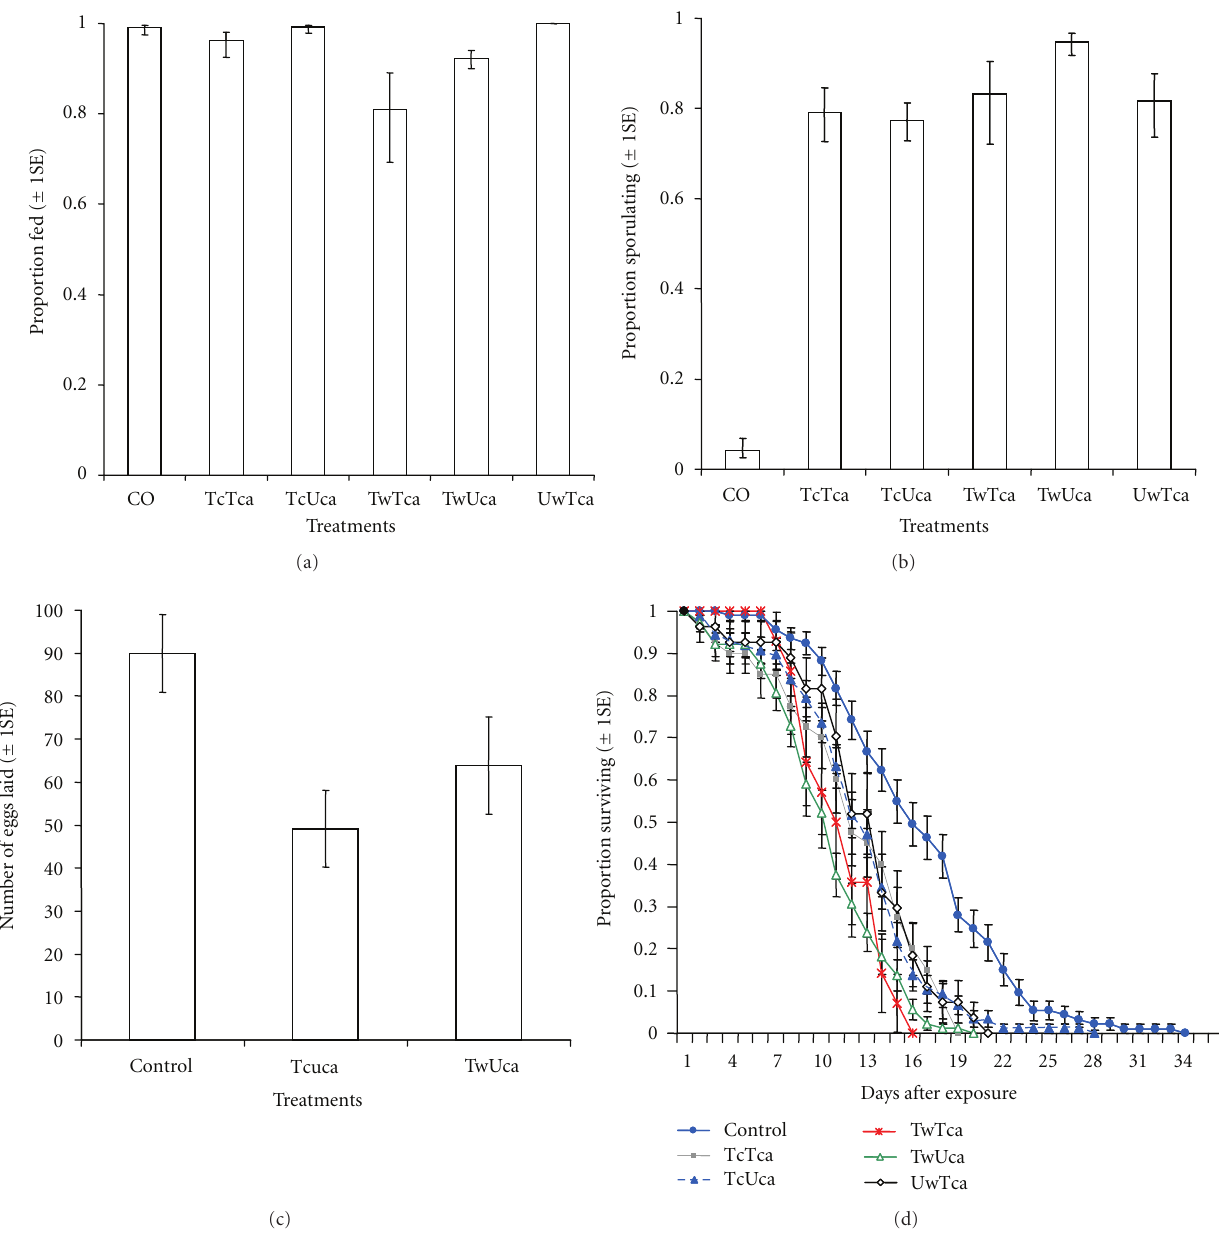
Figure 4: E ff ects of M. anisopliae IP 46 against wild exophilic An. arabiensis . (a) Estimated proportion ( ± 1s . e) of fed mosquitoes after exposure to fungus-treated and untreated calf inside experimental hut. (b) Estimated proportion ( ± 1s . e) of infected mosquitoes after exposure to fungus-treated and untreated surfaces. (c) Estimates ( ± 1s . e) of the mean number of eggs laid by mosquitoes after exposure to fungus-treated and untreated surfaces. (d) Survival of mosquitoes after exposure to fungus-treated and untreated surfaces. The lines represent the survival function as estimated from the fitting Cox proportional hazard model (controlling for random variation between individual